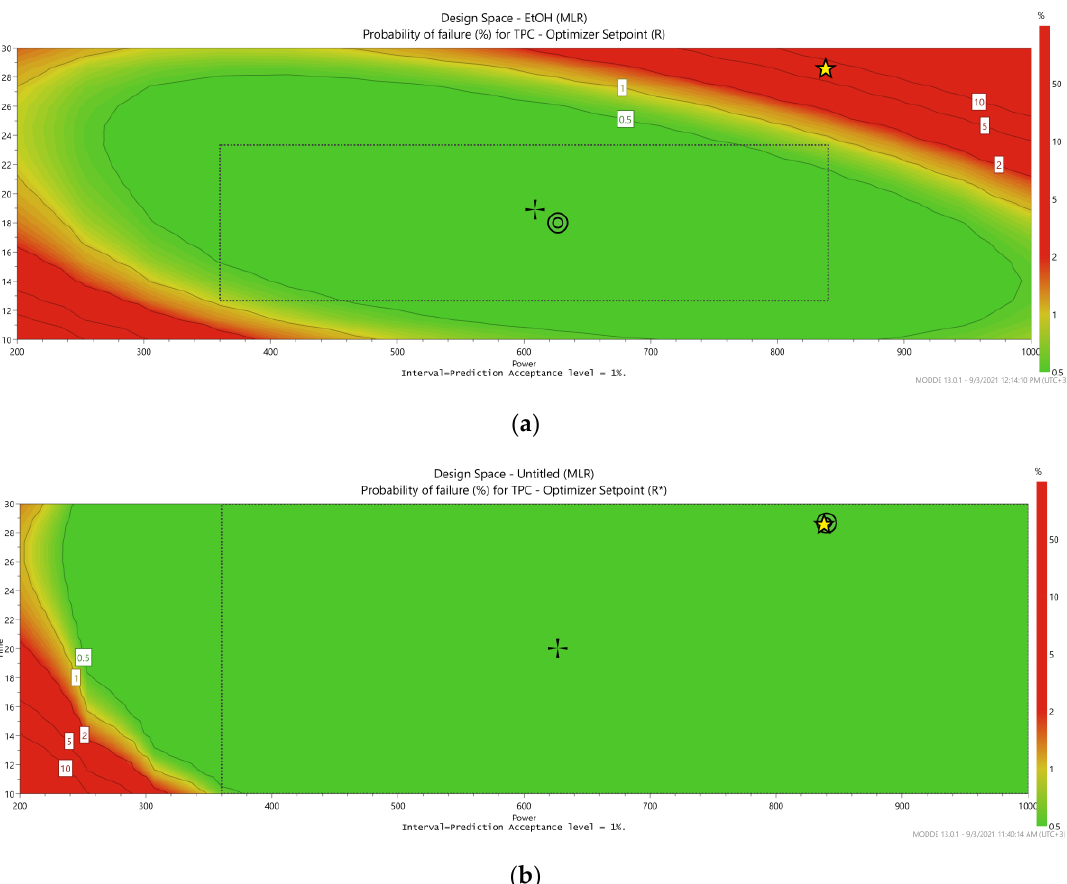
Figure 3. Design space for EtOH 70% extract ( a ) and water extract ( b ).